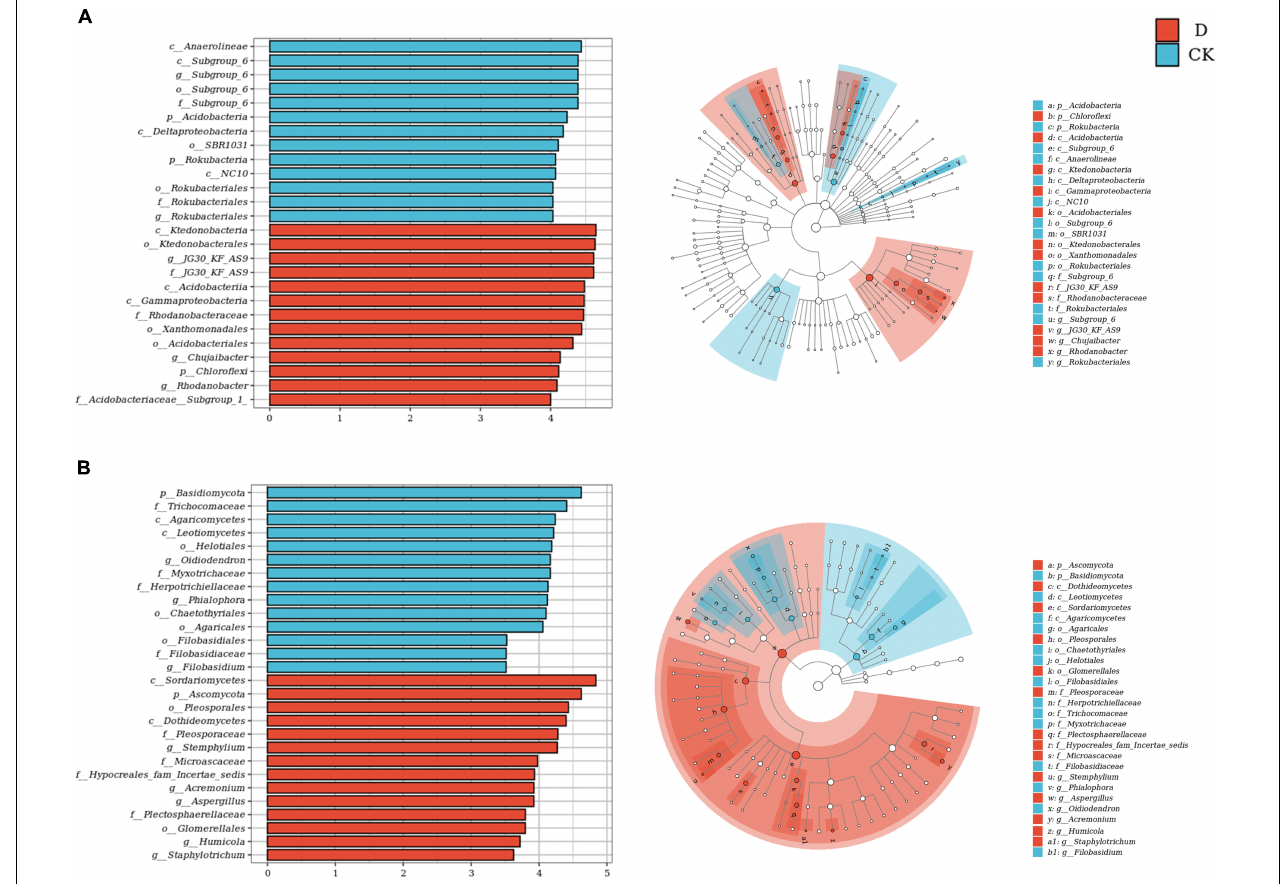
FIGURE 4 | Differential abundances of (A) bacterial and (B) fungal taxa in the garlic cropping obstacle soil (D) and healthy control soil (CK). The histogram shows taxa with LDA scores ≥ 4.0 for bacterial, and LDA scores ≥ 3.5 for fungal in the linear discriminant (LDA) effect size analysis. The cladogram shows taxonomic differences between D and CK.